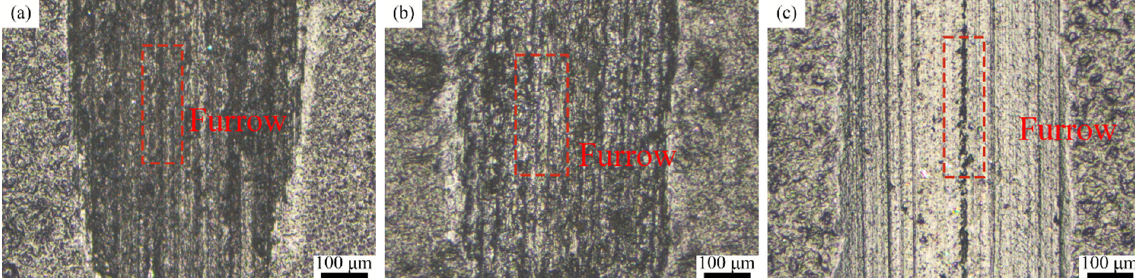
Figure 9. Wear marks of the composite coating under dry sliding wear. ( a ) T1.5 coating; ( b ) T2 coating; ( c ) T2.5 coating.